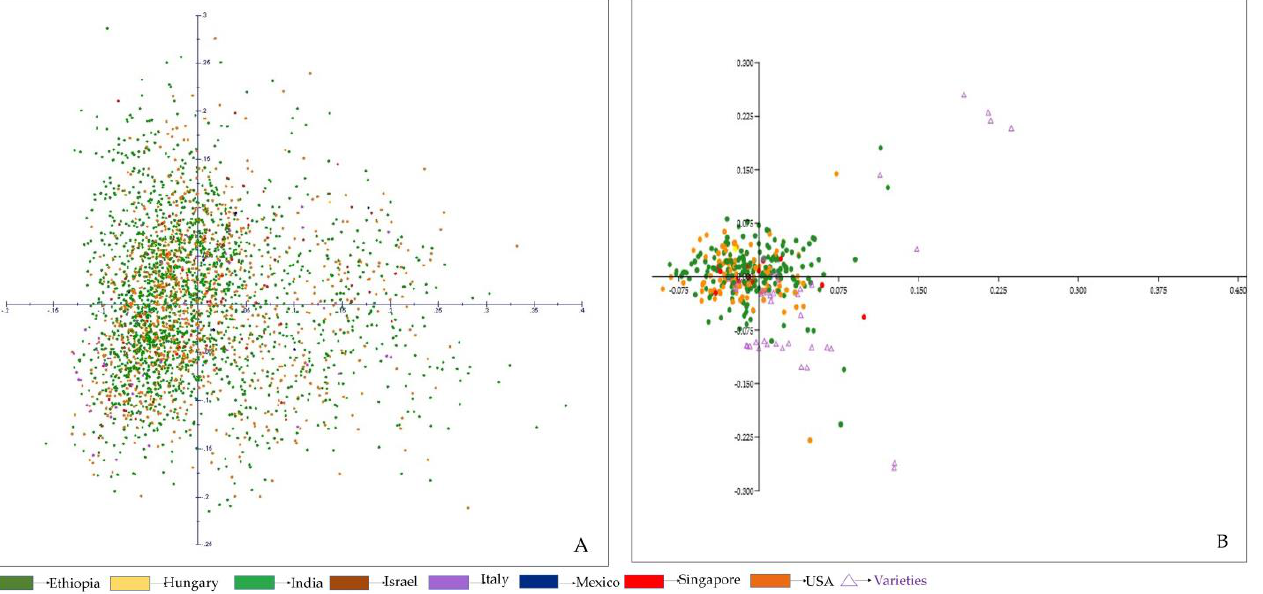
Table 4. AMOVA statistics of entire safflower accessions based on indigenous collections and exotic